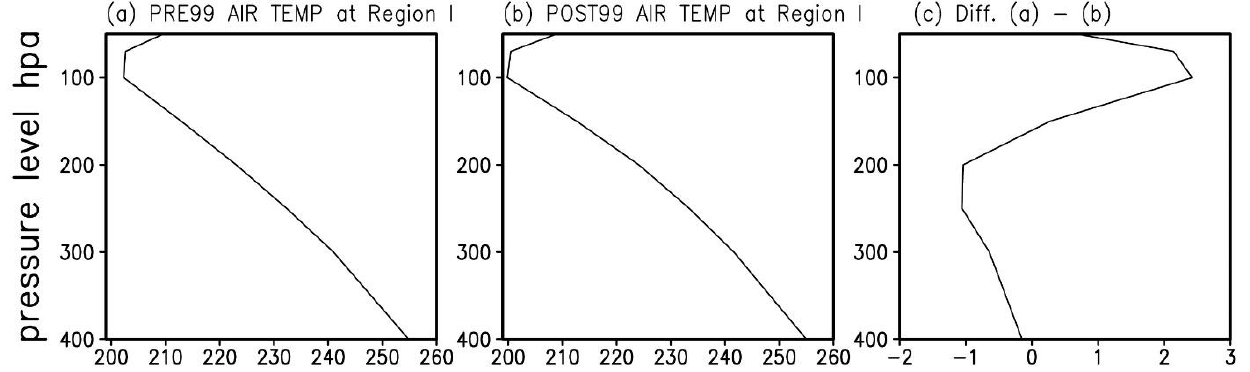
Figure 3. Vertical air temperature changes over Region I ( a ) PRE99 and ( b ) POST99. ( c ) The difference between ( a ) and ( b ), specifically, ( a ) - ( b ).